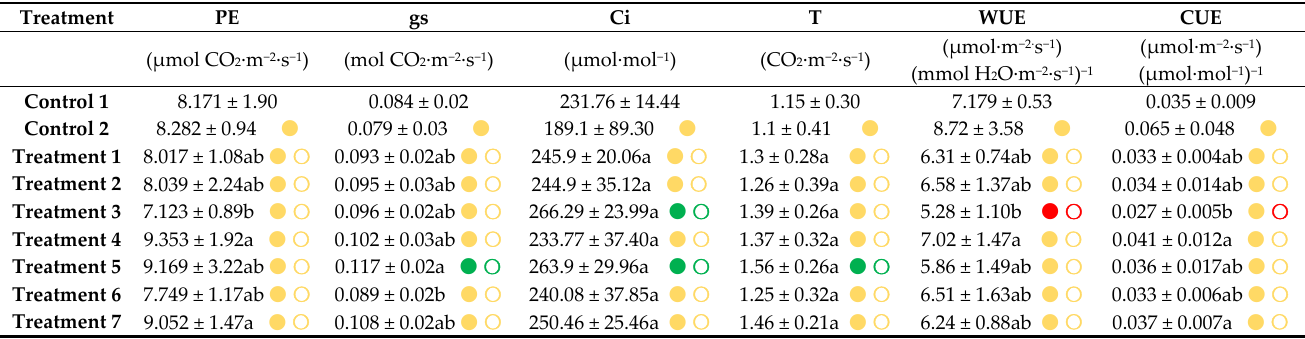
Closed ( ⬤ ) and open ( 〇 ) circles indicate comparisons withs Controls 1 and 2, respectively. Green, yellow, and red circles indicate that the values are higher than, equivalent to, or lower than those observed in the controls, according to the Kruskal–Wallis test ( p ≤ 0.05) and pairwise comparison with the Dunn test ( p ≤ 0.05). Means followed by the same letter do not differ statistically. Control 1: control without inoculation + fertilization 100% of N and P; Control 2: control without inoculation + fertilization 30% of N and P; Treatment 1: Azospirillum brasilense (Ab-v5), Treatment 2: Bacillus megaterium (0004); Treatment 3: Brevibacillus fluminis (MET12M2); Treatment 4: Ab-v5 + 0004; Treatment 5: Ab-v5 + MET12M2; Treatment 6: 0004 + MET12M2; Treatment 7: Ab-v5 + 0004 + MET12M2.